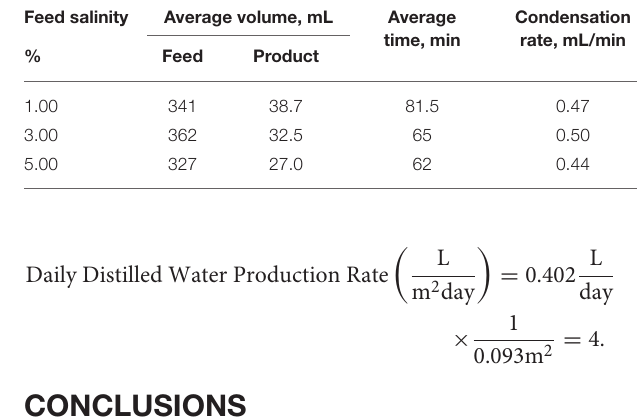
TABLE 2 | Average advanced desalination condensate production rate. Feed